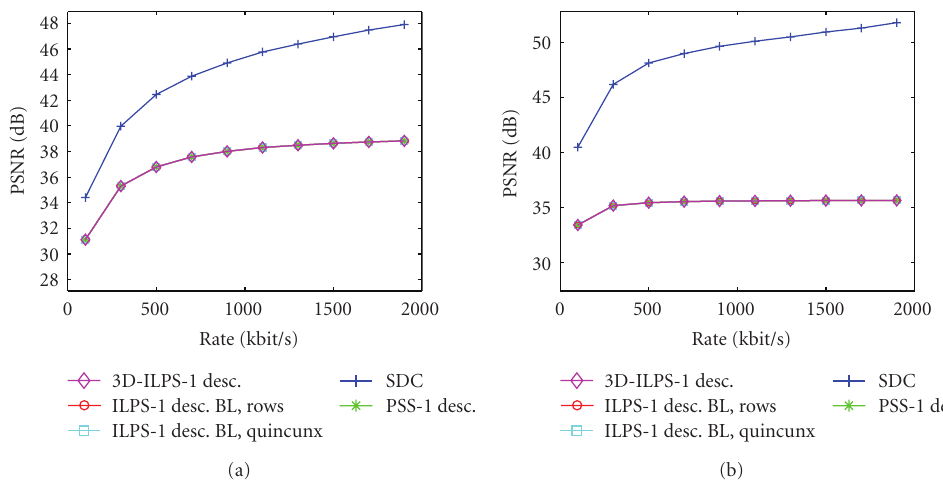
Figure 4: Performance of color view, one subsequence received. (a) Breakdance. (b) Ballet.